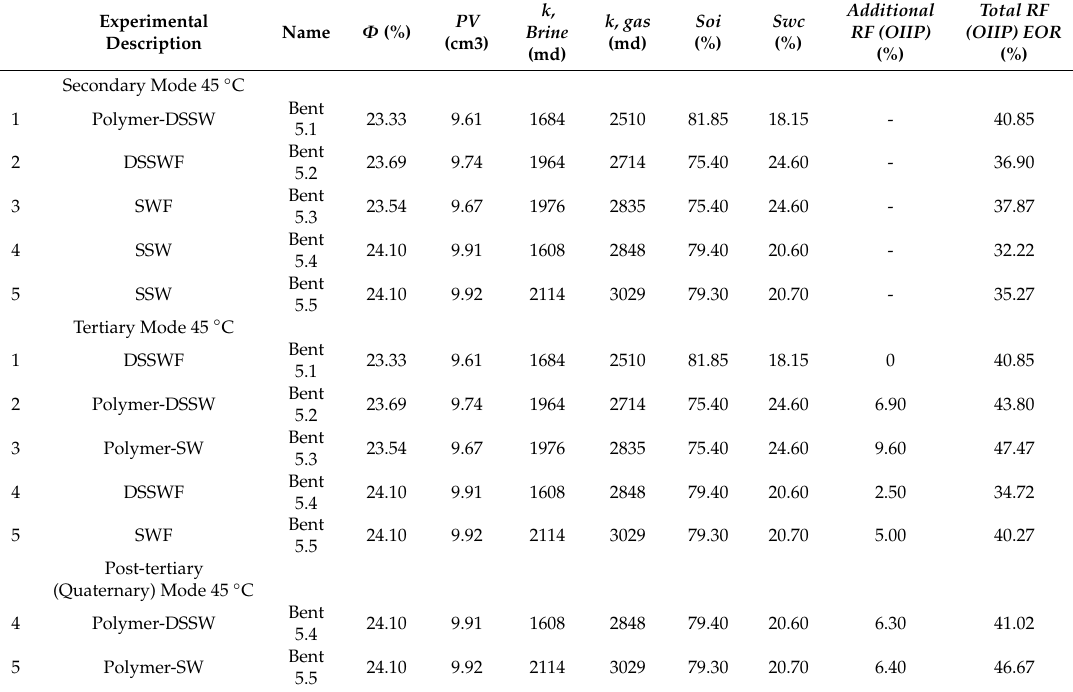
Table 5. Summary and comparison of core flood recoveries and flooding processes.